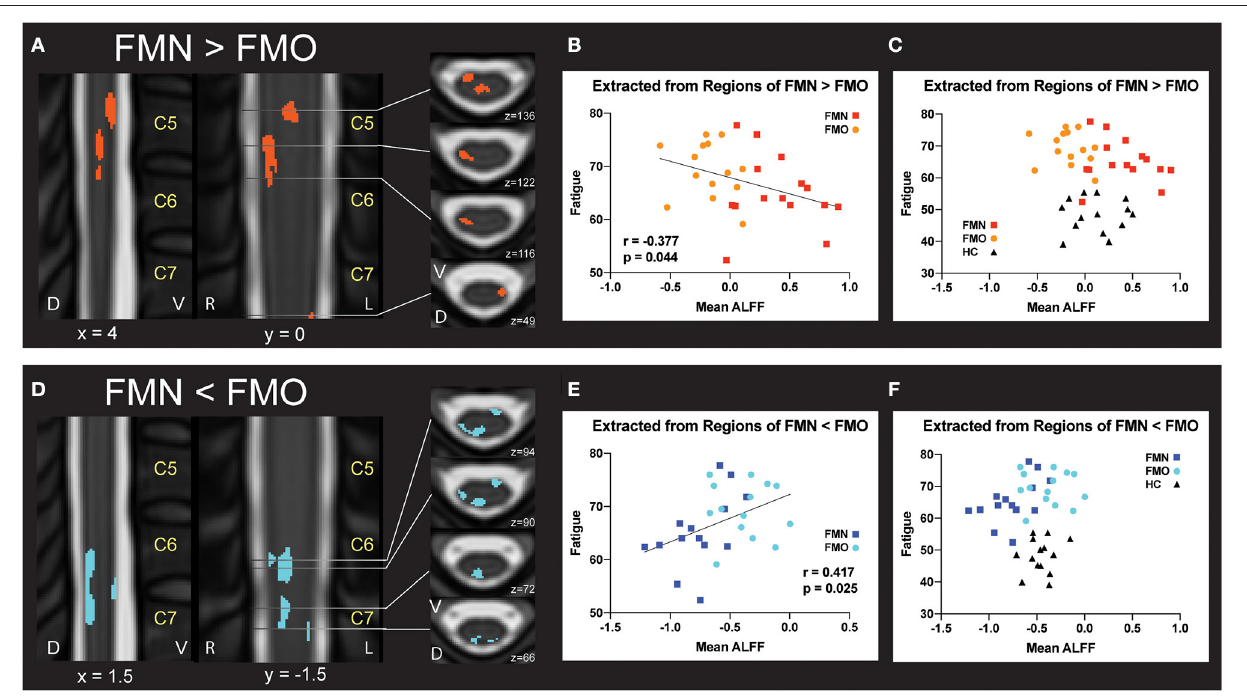
FIGURE 4 | Correlations between regional mean ALFF and fatigue. (A) Regions of greater Mean ALFF were identified in fibromyalgia patients who were not taking opioids (non-opioid FM, FMN) vs. patients taking opioids (opioid FM, FMO). (B) Individually extracted regional Mean ALFF values were negatively correlated with fatigue across patient groups. (C) Healthy control values are plotted for visual comparison only. (D) Regions of lesser Mean ALFF were identified in fibromyalgia patients who were not taking opioids (non-opioid FM, FMN) vs. patients taking opioids (opioid FM, FMO). (E) Individually extracted regional Mean ALFF values from FMN < FMO regions were positively correlated with fatigue across patient groups. (F) Healthy control values are plotted for visual comparison only. Sagittal images are indicated with “x” coordinate locations, coronal images are indicated with “y” coordinate locations, and axial images are indicated with “z” coordinate locations based on the PAM50 template ( 23). ALFF, amplitude of low frequency fluctuations; D, dorsal; FM, fibromyalgia; FMN, non-opioid FM; FMO, opioid FM; HC, healthy controls, L, left; R, right; V, ventral. P -values are uncorrected < 0.05.